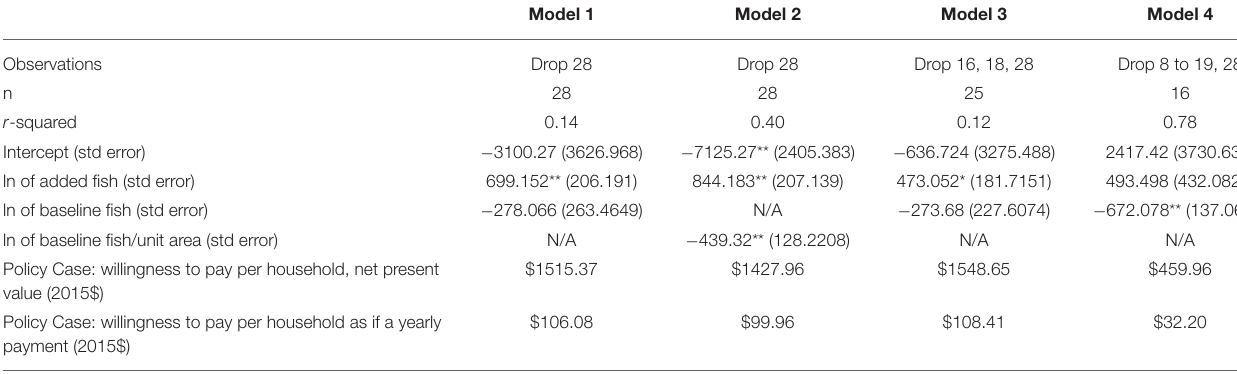
TABLE 4 | New meta-regression of the total economic value of migratory pacific salmon abundance changes in the